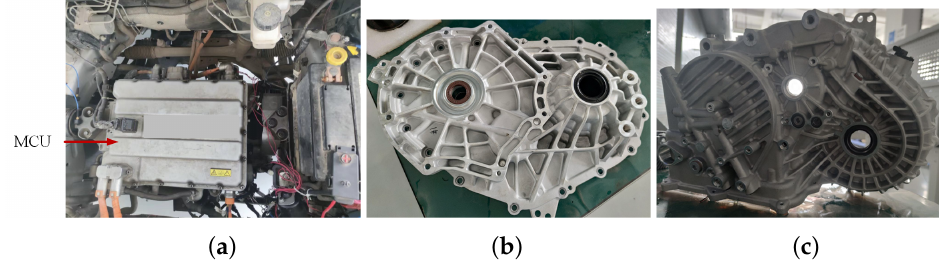
Figure 18. ( a ) Front-end view of measured vehicle. The transmission is located under the MCU. ( b ) Front gearbox housing after optimization. ( c ) Rear gearbox housing after